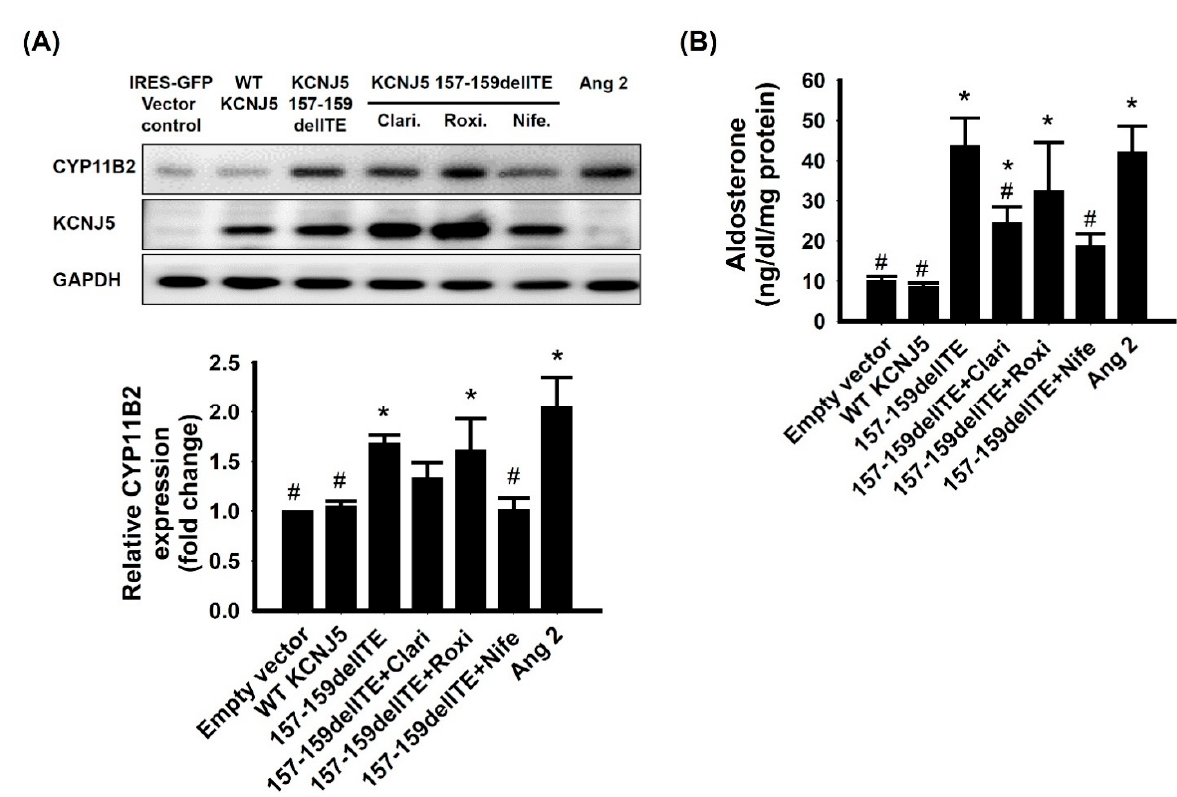
Figure 4. KCNJ5 157-159delITE mutation increased CYP11B2 expression and aldosterone production through calcium- mediated pathway. The HAC15 cells were transiently transfected with wild-type or mutant KCNJ5 . At 72 h after transfection, the samples and culture medium were collected and analyzed. ( A ) The CYP11B2 and KCNJ5 protein expression of cells harboring KCNJ5 mutant were significantly more than wild-type cells. The macrolides, clarithromycin or roxithromycin did not affect the CYP11B2 expression of cells harboring the KCNJ5 mutant. ( B ) The aldosterone production of cells harboring KCNJ5 mutant was significantly more than wild-type cells. The clarithromycin could partially inhibit aldosterone production of the KCNJ5 mutant cells. However, the roxithromycin could not inhibit aldosterone production of KCNJ5 mutant cells. Aldosterone production from HAC15 were adjusted by total protein. * indicated p < 0.05 vs. wild-type KCNJ5 group, # indicated p < 0.05 vs. 157-159delITE group. The macrolides were used as the inhibitors of mutant KCNJ5 channel. Nifedipine was used as inhibitor of downstream of KCNJ5 -related pathway. Angiotensin II was a stimulator of aldosterone